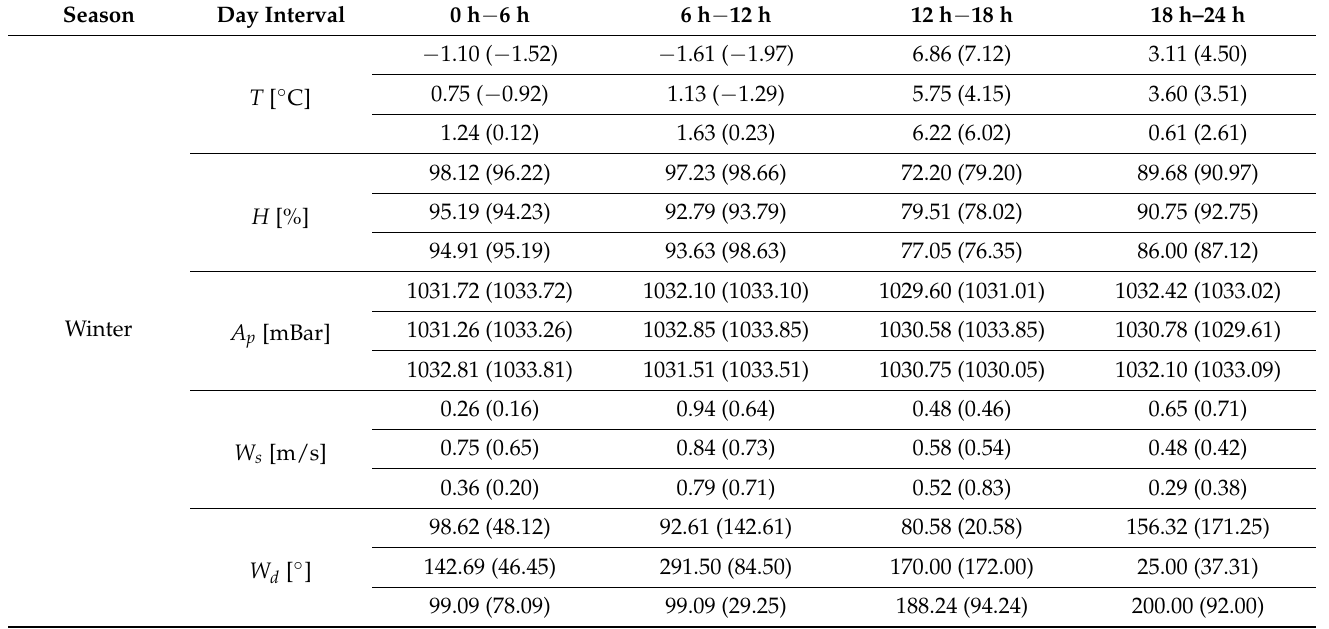
Table 4. Average meteorological variables in different seasons and day intervals of a working weekday, Saturday, and Sunday listed in three successive rows for each